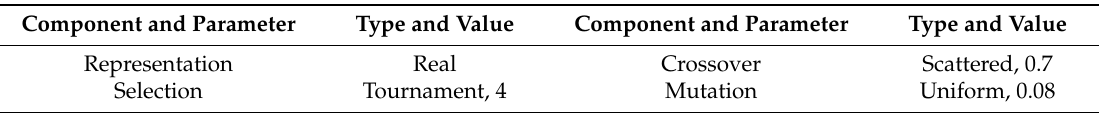
Table 3. Components and initial parameters of the Monte Carlo Genetic Algorithm (GA) and the Noisy Genetic Algorithm (NGA).